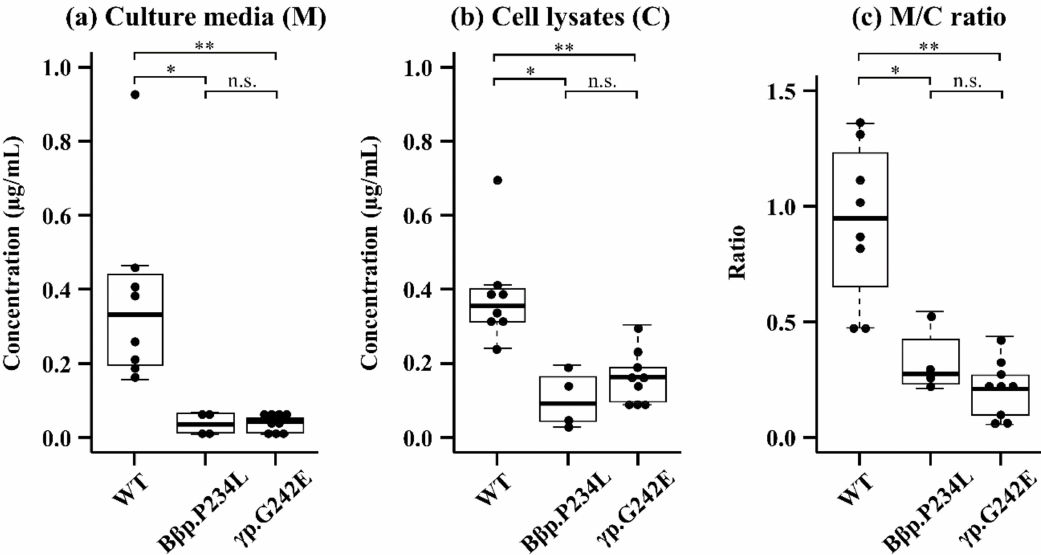
Figure 2. Secretion and synthesis of fibrinogen in Chinese hamster ovary (CHO) cells. Fibrinogen concentrations in the culture media (Panel ( a )) and cell lysates (Panel ( b )) were measured using ELISA. Panel ( c ) shows the ratio in the medium to the cell lysate. Box plots and the central bar show the interquartile range and median, respectively. The whiskers indicate the minimum and maximum value excluding outliers. Dots represent individual values. Concentrations were assessed for clones expressing wild-type (WT, n = 8), B β p.P234L ( n = 4), and γ p.G242E ( n = 9). The significance of di ff erences among WT and variant fibrinogen-producing CHO cells was assessed using the Kruskal-Walls test and the Steel-Dwass test. * p < 0.05; ** p < 0.01; n.s.: